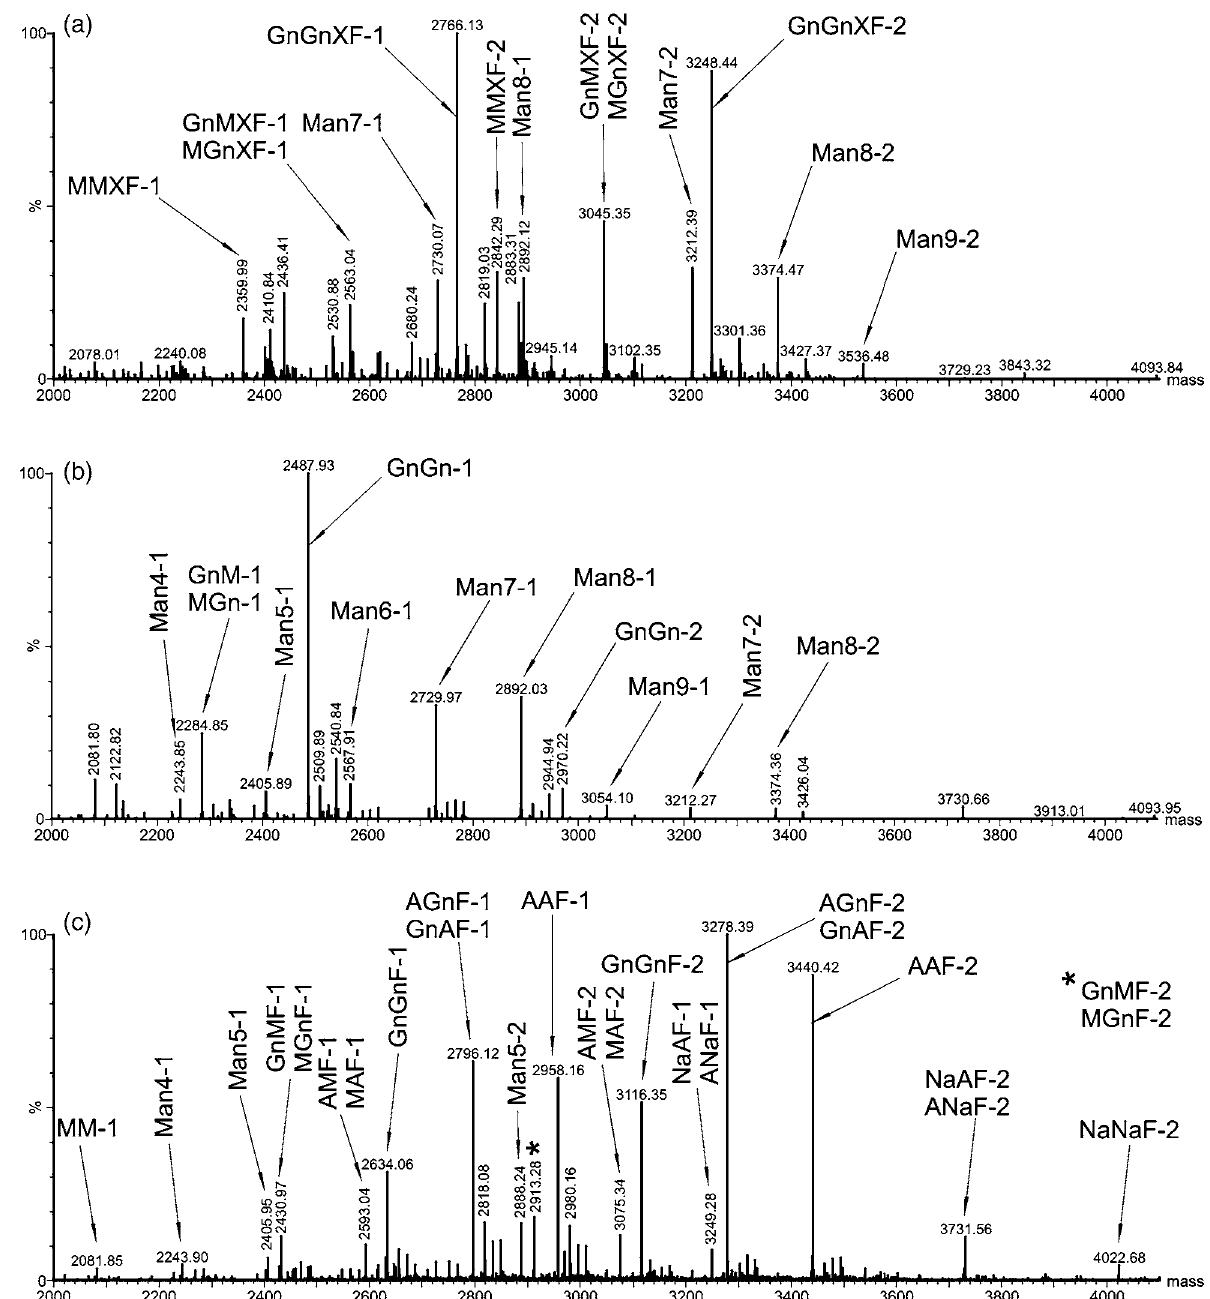
Figure 4 Liquid chromatography-mass spectrometry (LC-MS) of glycosylated peptides (-1, EEQY N STYR; -2, TKPREEQY N STYR) containing asparagine- 297 from the 2G12 Fc region: (a) glycopeptides derived from wild-type (wt)-produced 2G12; (b) glycopeptides derived from β 1,2-xylosyltransferase and α 1,3-fucosyltransferase knockout (XT/FT k.o.) plant-produced 2G12; (c) glycopeptides derived from Chinese hamster ovary (CHO)-produced 2G12. See http://www.proglycan.com for an explanation of N -glycan